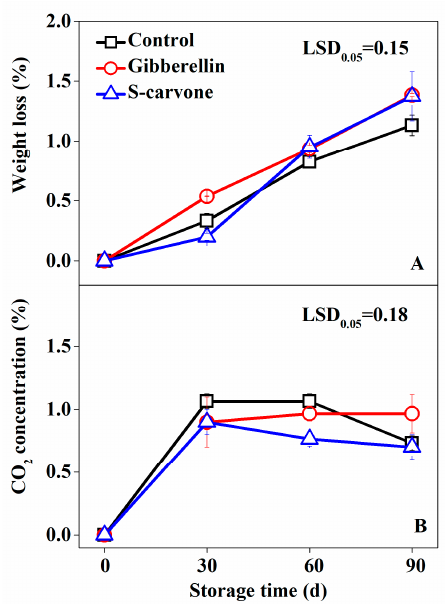
Figure 3. Effects of gibberellin and ( S )-carvone on physiological response in potato tubers during 4 °C low temperature storage. ( A ) Gibberellin and ( S )-carvone effect on weight loss. ( B ) Gibberellin and ( S )-carvone effect on CO 2 concentration. The error bars represent the standard errors. LSDs represent least significant differences at the 0.05 level.